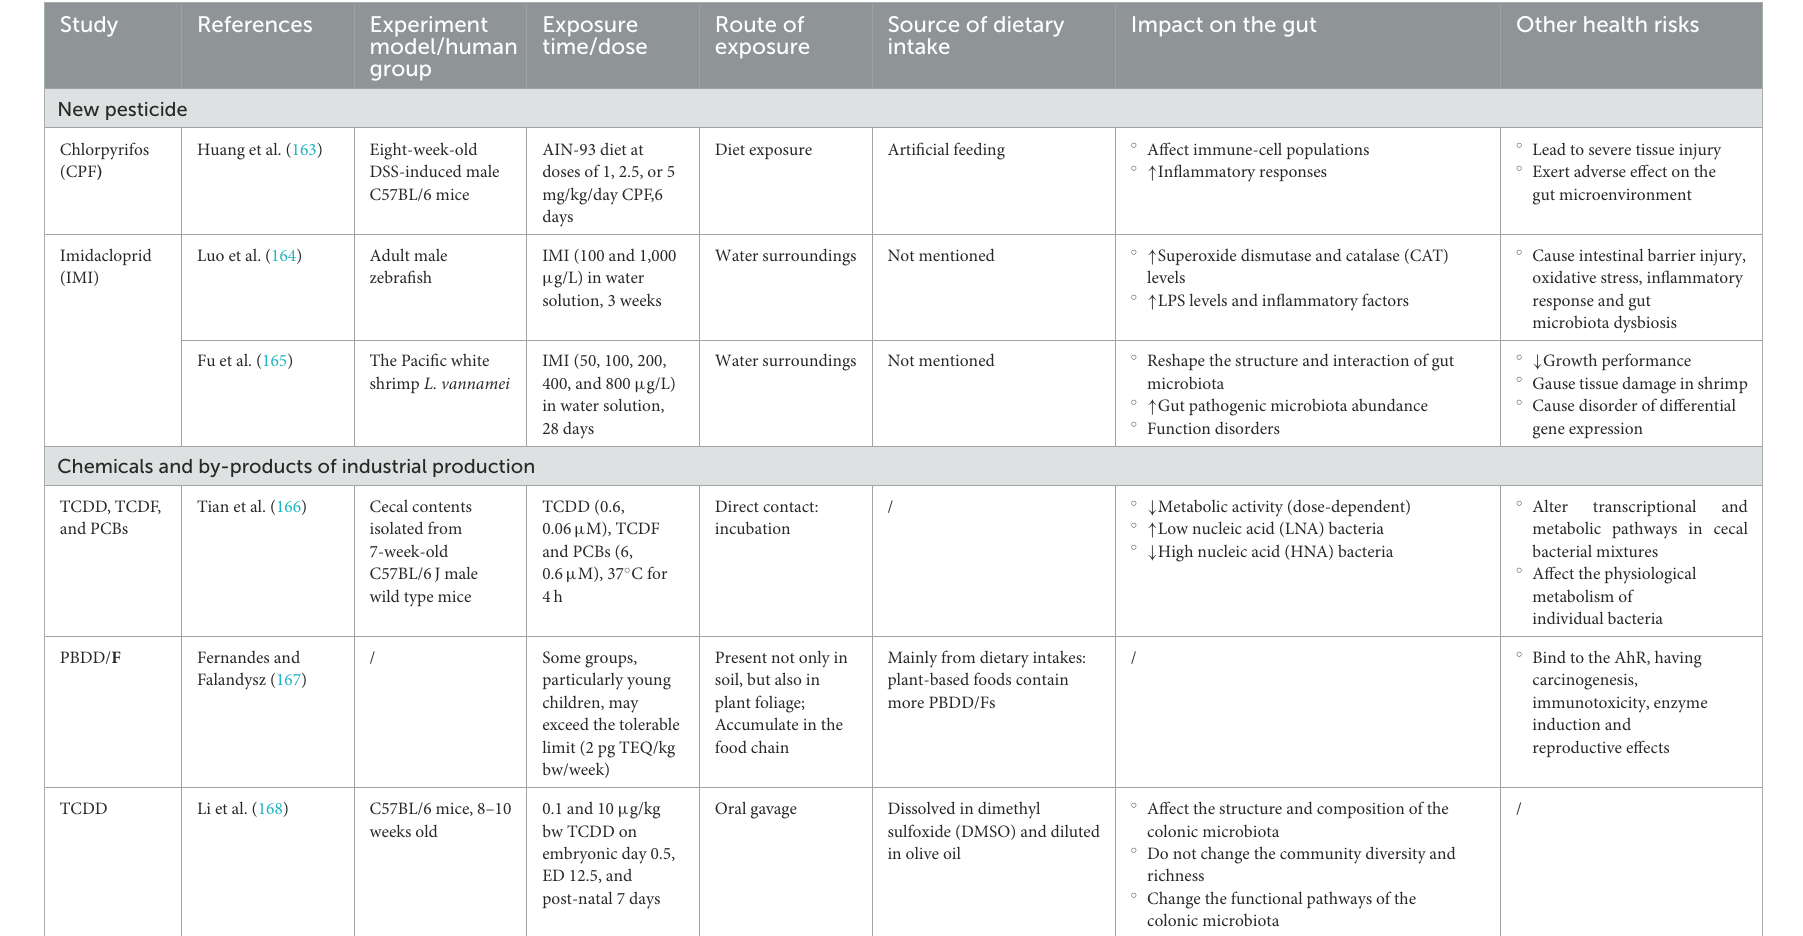
TABLE 5 Adverse health effects of POPs in inflammatory bowel disease.